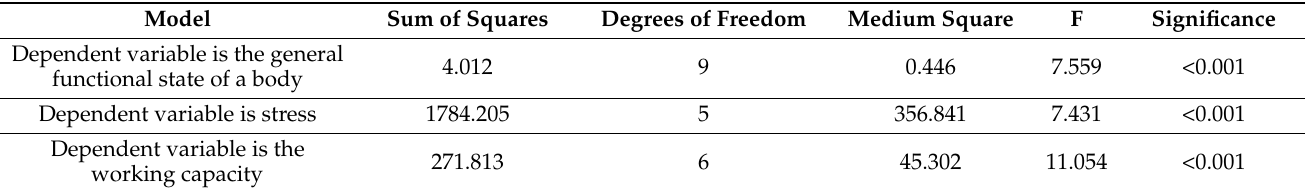
Table 4. ANOVA for regression models.